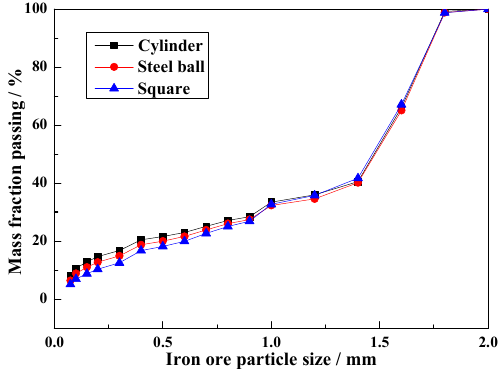
Figure 17. Iron ore particle size distribution.